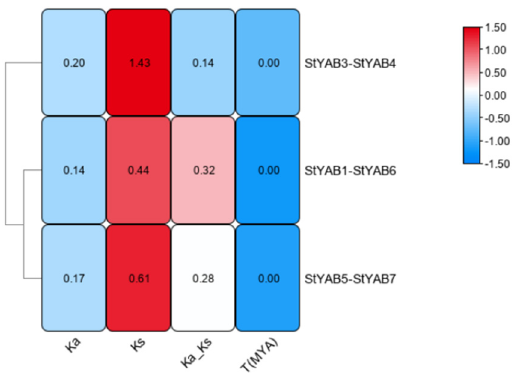
Figure 4. The time of gene duplication was estimated for the different paralogous pairs of the potato StYAB genes on the basis of Ks and Ka values. The analyses were conducted using Tbtools v 1.108. Ka/Ks represents the ratio of nonsynonymous (Ka) versus synonymous (Ks) mutations.